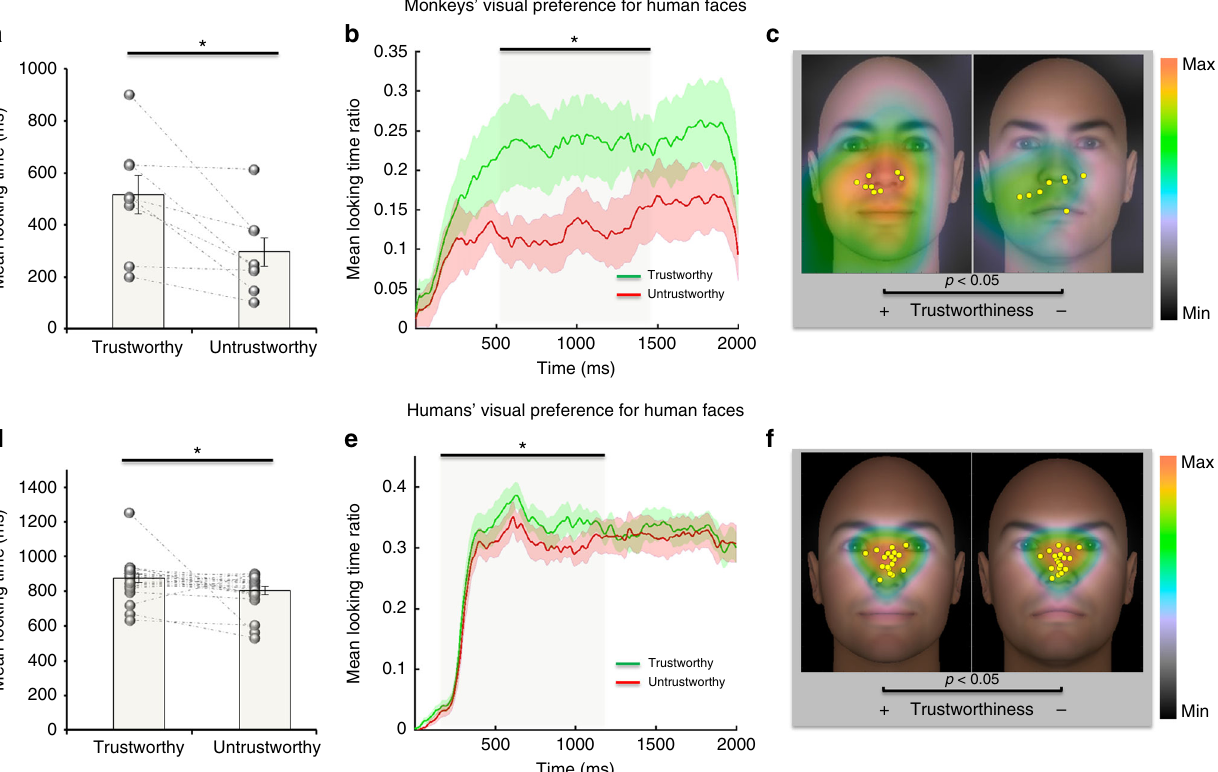
Fig. 2 Monkeys and humans ’ visual preference for trustworthy faces. MONKEYS ( N = 8): a Mean looking time in milliseconds (ms) for the most trustworthy ( + 3 SD of the neutral face) and the least trustworthy ( − 3SD of the neutral face) versions of the same facial identities selected from the Todorov ’ s Database 46,65 . Circles indicate individual data points connected by dashed lines for each individual. Error bars indicate S.E.M. across 8 subjects. * p < 0.05, paired-sample t -test. Monkeys looked signi fi cantly longer at the two faces than predicted by chance and looked more at trustworthy than untrustworthy faces. b Time course of looking preference. Mean viewing time ratio between each facial prototype. A cluster-based permutation test showed that preference for the trustworthy faces (green line) was signi fi cant between 510 ms and 1485 ms ( P < 0.05 corrected for multiple comparison). c Gaze heat maps for trustworthy and untrustworthy faces averaged across subjects (trustworthy face on the left by convention, facial prototype spatial location was counterbalanced within and between subjects). Yellow dots show fi xation centers of gravity for each subject. HUMANS ( N = 20 ) ( d – f ) Plot ( d ) show signi fi cantly longer mean looking times at trustworthy than untrustworthy faces. Error bars indicate S.E.M. across 20 subjects. Plot ( e ) show the